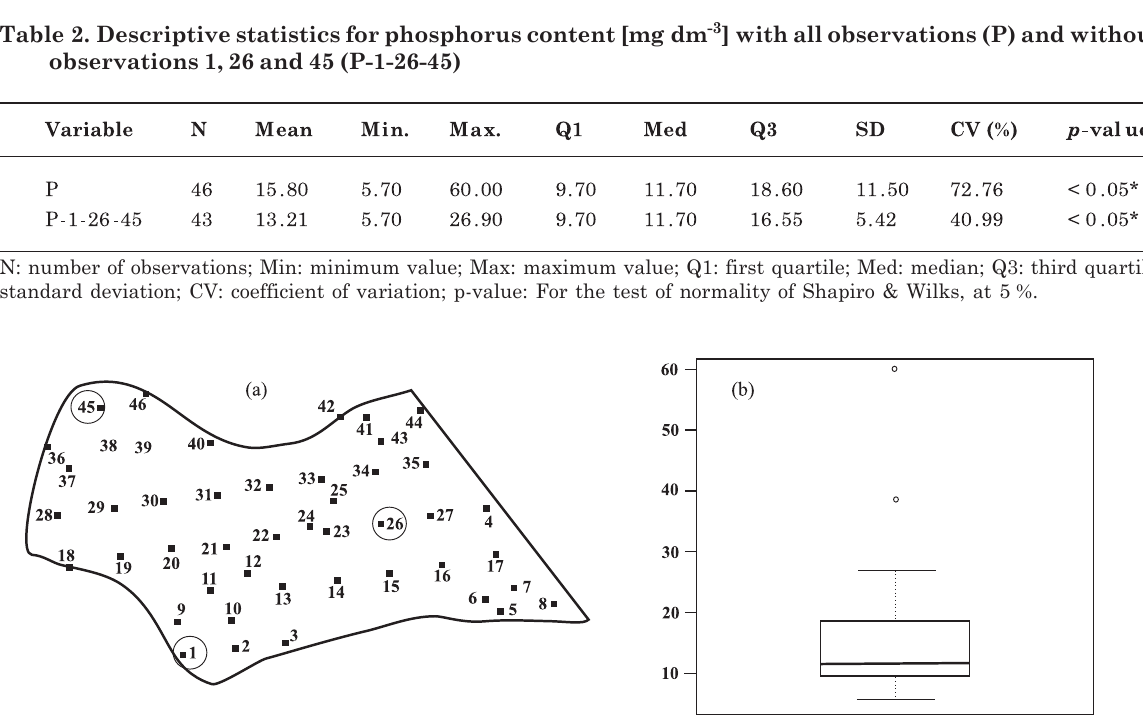
Figure 10. (a) Arrangement of sampled points in the study area of 71 ha. (b) Box-plot for P content in full